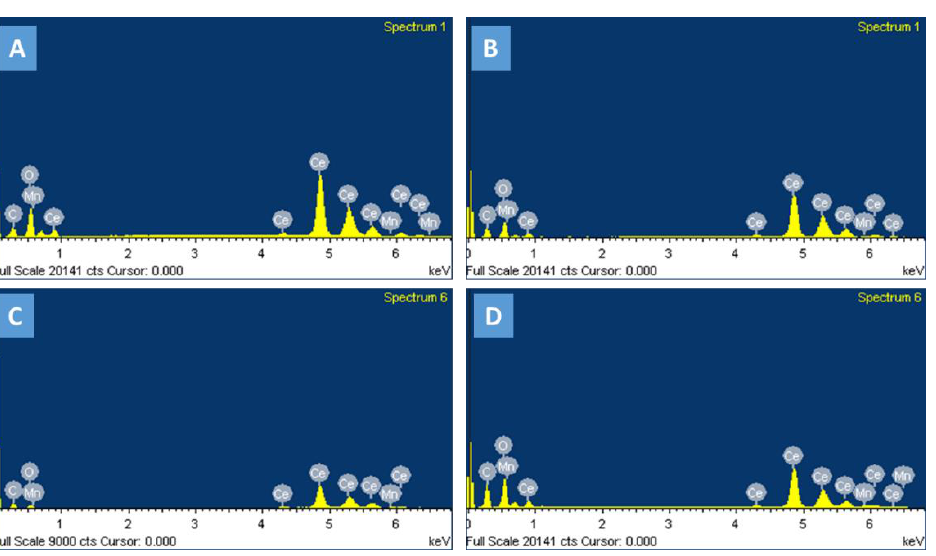
Figure 6. HR-TEM micrograph for Mn-CeO 2 (1%) and Mn-CeO 2 (10%) samples. 2.2. The Photocatalytic Study At the beginning of the photocatalytic study, several blank reactions were carried out to confirm the photocatalytic decolorization of the dye. The blank reactions included the photolysis experiment, in which the dye solution was kept under visible light for 120 min.